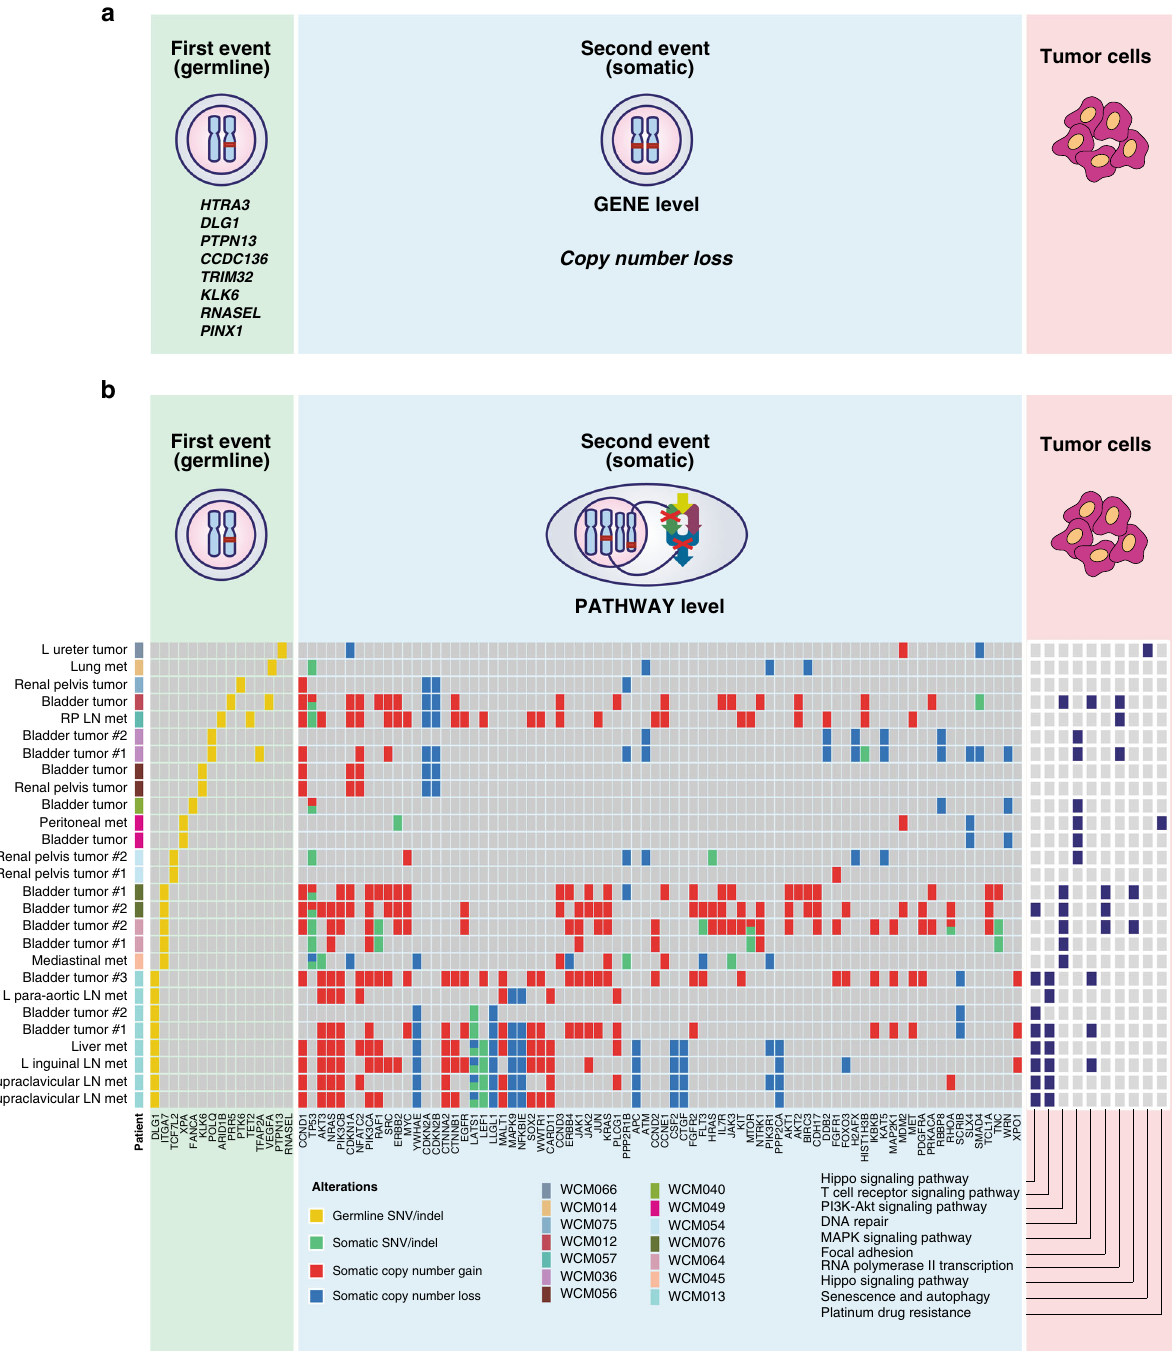
Fig. 6 Germline and Somatic interactions in the urothelial cancer genome. a Schematic view of germline-somatic interactions at the gene level. Genes with somatic copy number losses were identi fi ed in eight WCM-UC patients. b Select pathway-level interactions between pDGVs and somatic genomic alterations in individual tumors from each patient. The complete list of somatic alterations is presented in Supplementary Fig. 8. Source data are provided as a Source Data fi